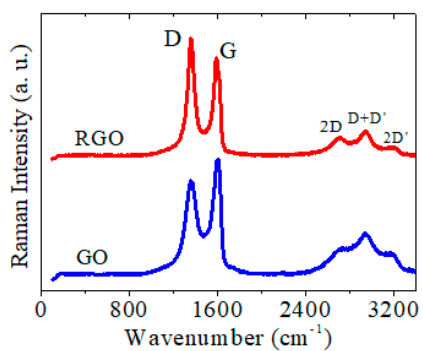
Figure 6. Raman spectra of GO and RGO (obtained by electrochemical reduction of GO films by five CV cycles from 0 to − 1.5 V, 0.05 V/s, in 0.5 M KCl).